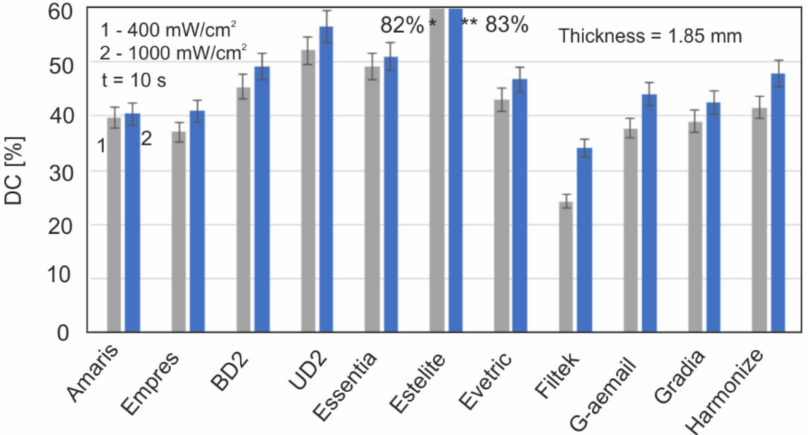
Figure 7. Comparison of the maximum DC values for the tested materials. * DC for Estelite (400 mW/cm 2 ) ** DC for Estelite (1000 mW/cm 2